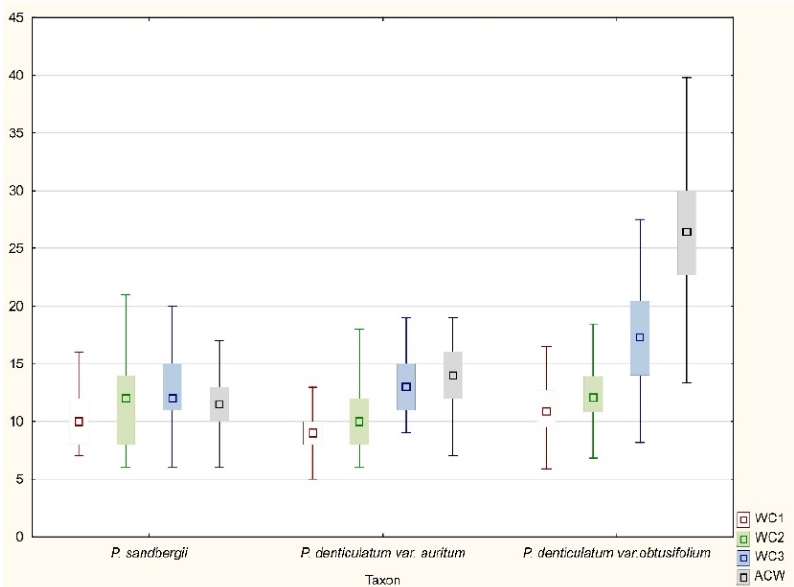
Figure 16. The variability range of the examined features. Explanation: WC1, width of cells from the top; WC2, the middle part; WC3, from the lower part of the leaf; ACW, width of alar cells (length in µ m).